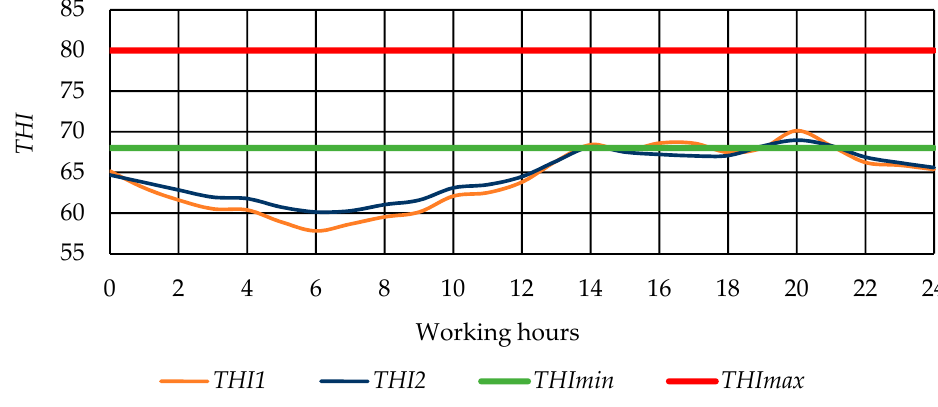
Figure 10. THI dynamics on a moderate day (maximum temperature of 21.9 °C ).